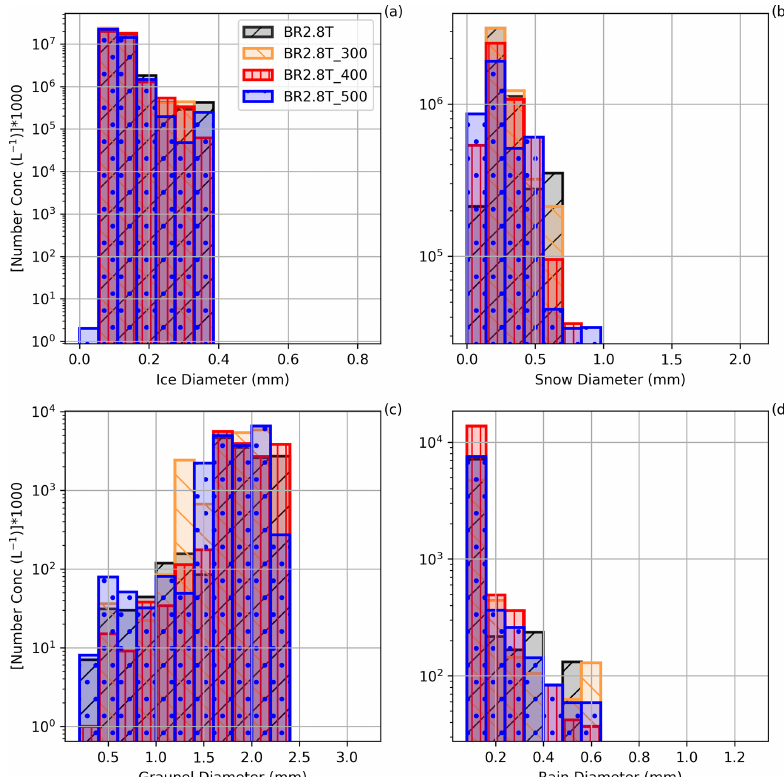
Figure C1. Particle size distribution over the number concentrations for panels (a) ice, (b) snow, (c) graupel, (d) cloud droplets and (e) rain- drops for all the sensitivity simulations at 15:30UTC. BR2.8T, BR2.8T_300, BR2.8T_400 and BR2.8T_500 represents the size restriction